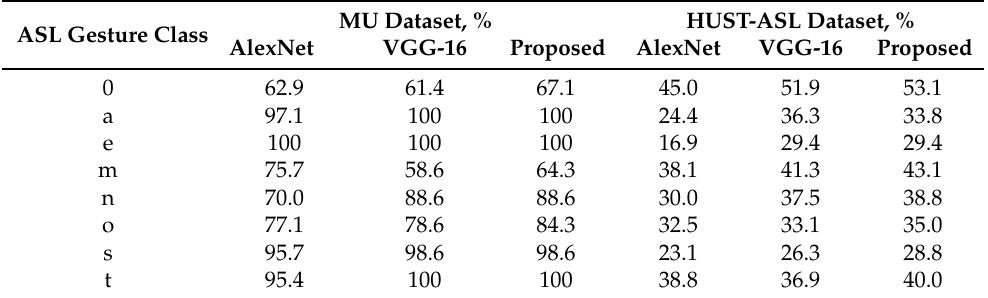
Table 6. Error analysis on ASL hand gesture datasets without any fingers held out.